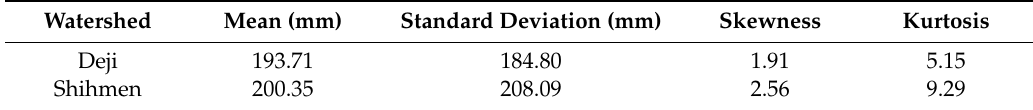
Table 3. Statistical parameters of monthly rainfall series for the two Reservoir